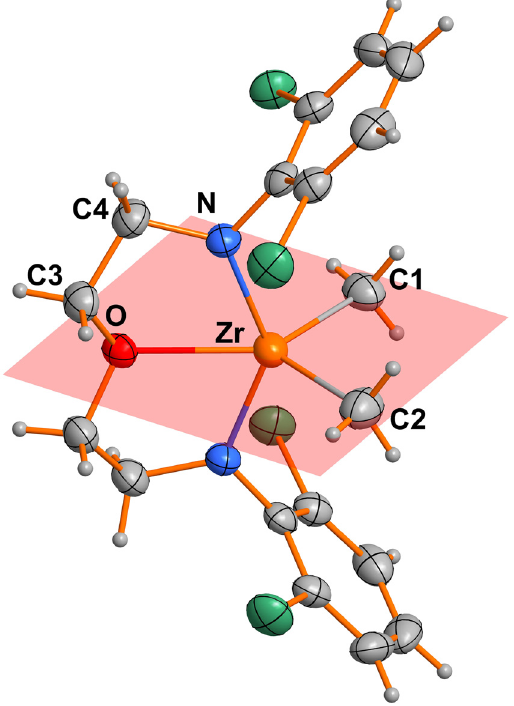
Table  : Data collection and